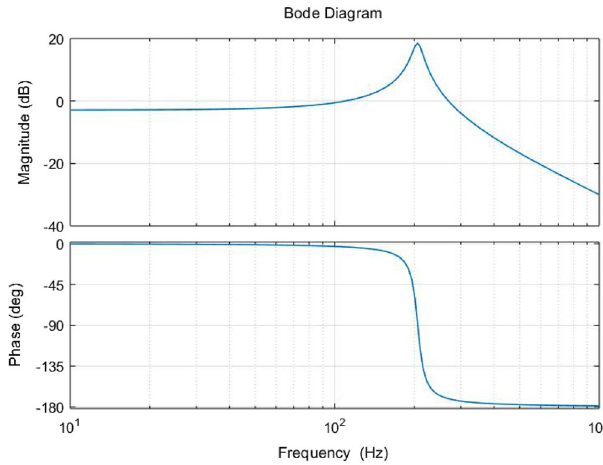
Figure 5. Open-loop Bode diagram for nominal system G 0 .